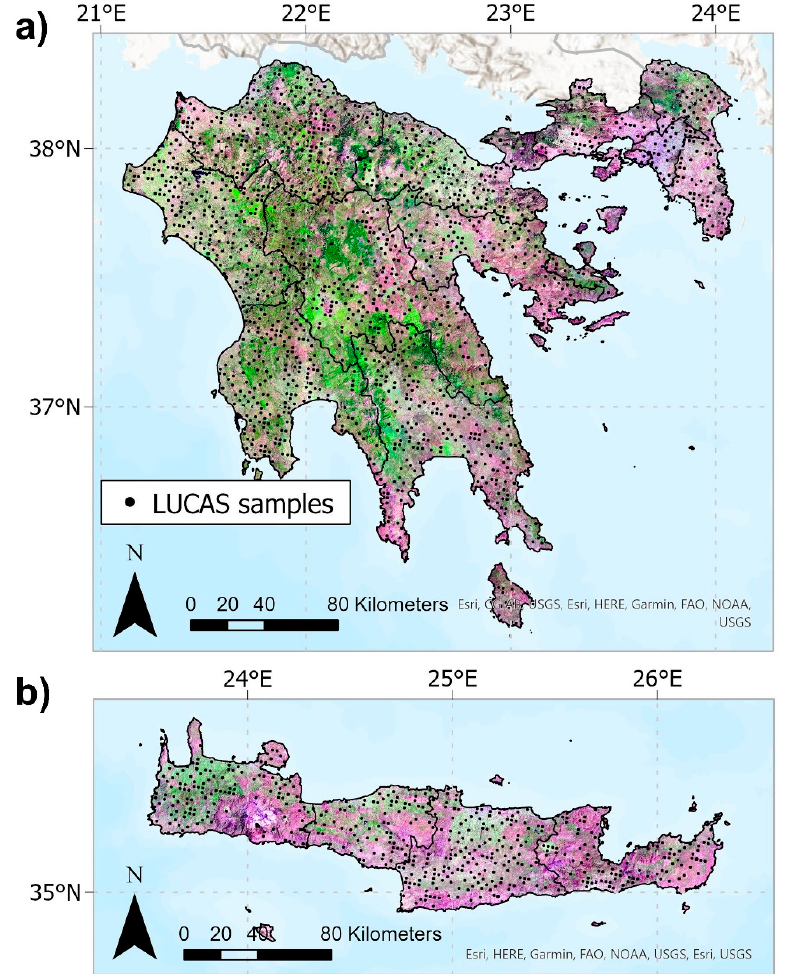
Figure 3. Distribution of LUCAS samples across: ( a ) Attica and the Peloponnese peninsula and ( b ) Crete. Samples are overlaid on Landsat 8 data for the 2020 summer season (June, July, August). Image composite RGB channels represent 90th percentile SWIR1 reflectance, 90th percentile NIR reflectance, and 90th percentile red reflectance, respectively.